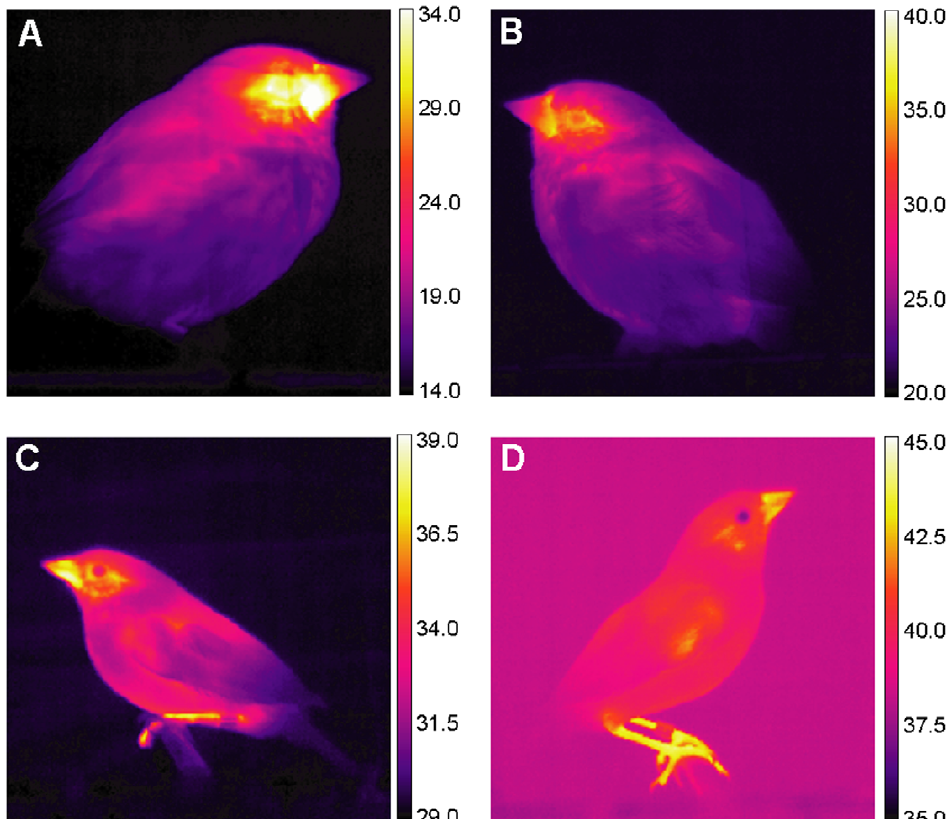
Figure 1. Infrared images of eastern and Atlantic song sparrows. Eastern (A) and Atlantic (B–D) song sparrows were imaged at ambient temperatures of 15 (A), 21 (B), 29 (C), and 37 u C (D).